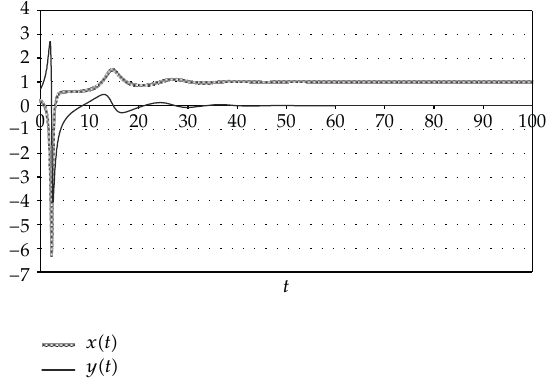
Figure 7: x (cid:2) 0 (cid:3) (cid:6) 0.2, y (cid:2) 0 (cid:3) (cid:6) 0.7, a (cid:6) 0.1, b (cid:6) 0.5, alpha (cid:6) 1.0.